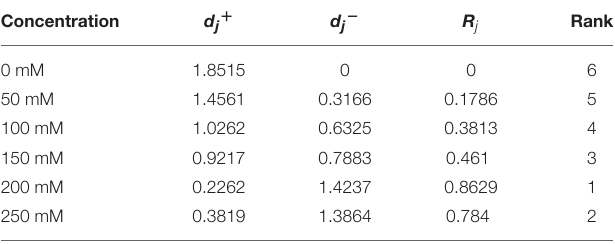
TABLE 2 | Appropriate treatment concentration evaluated by the TOPSIS method. Concentration d j +